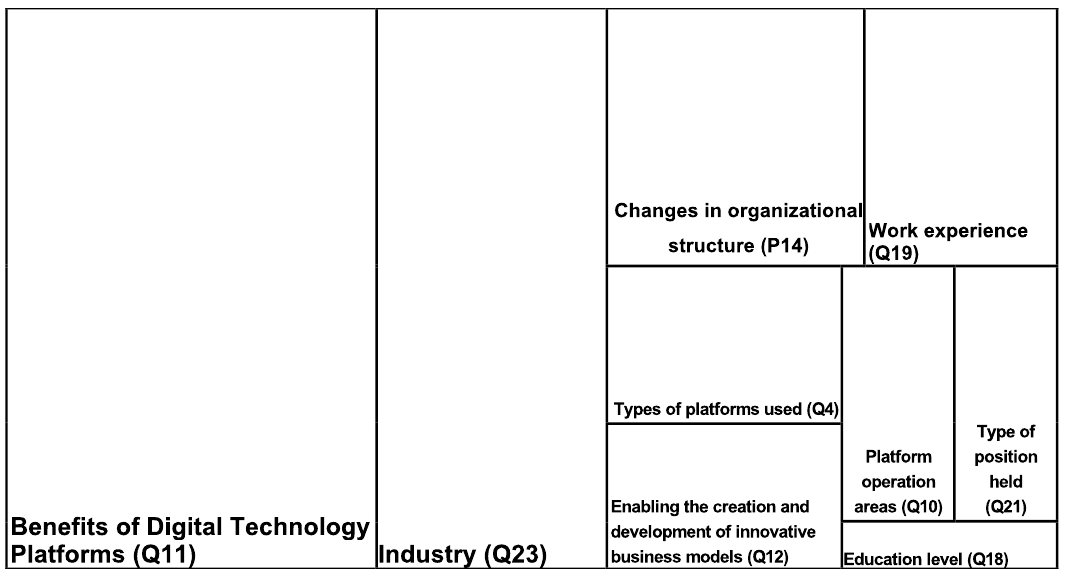
Figure 1. Proportion of importance of the components of the optimal scaling model.